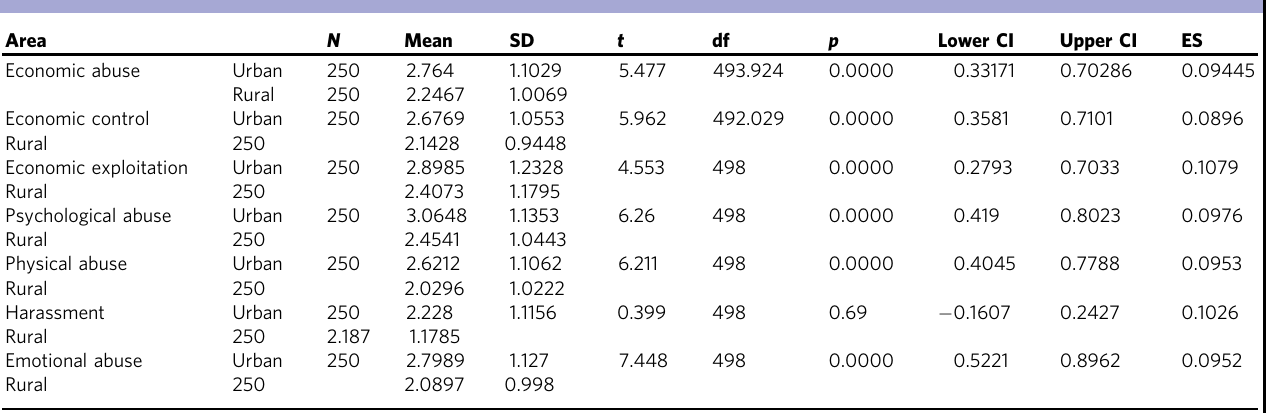
Table 7 Independent sample t -test for area differences in economic abuse, economic control, economic exploitation, psychological abuse, physical abuse, harassment, and emotional abuse for urban and rural